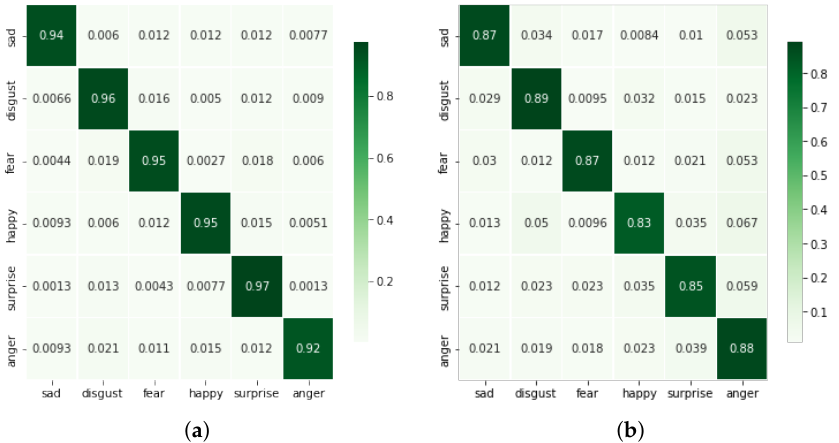
Figure 7. A comparison of confusion matrices computed with the proposed approach using 6D acceleration and angular velocities ( a ) and computed by [19] et al., using SVM trained with top 150 features ( b